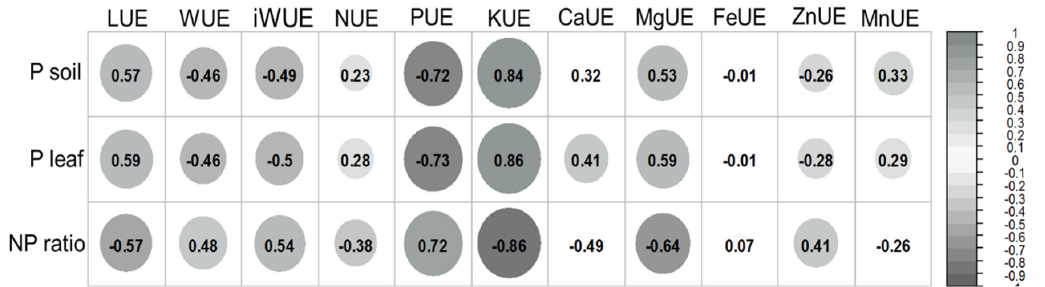
Figure 4. Correlation between phosphorus availability and resource use efficiency of Bertholletia excelsa saplings in a P-deficient Amazon Ferralsol. The significant correlations are represented by a gray circle, and the larger and darker the circle, the stronger the correlation. Abbreviations: LUE, light use efficiency; WUE, water use efficiency; iWUE, intrinsic water use efficiency; NUE, nitrogen use efficiency; PUE, P use efficiency; KUE, potassium use efficiency; CaUE, calcium use efficiency; MgUE, magnesium use efficiency; FeUE, iron use efficiency; ZnUE, zinc use efficiency; MnUE, manganese use efficiency. Phosphorus fertilization was shown to increase the total dry biomass of the saplings (Figure 5a,b). The increase in dry biomass values was observed from 200 mg P kg − 1 added in soil (Figure 5b), with greater values in plants subjected to 400 mg P kg − 1 , which showed total dry biomass that was 66% greater than the control. The maximum point of the curve occurred at the coordinates x = 306.2 mg P kg − 1 and y = 49.9 g (Figure 5b). In the control plants, about 21% of dry biomass was allocated to roots, while in plants under P only 16% of dry biomass was allocated to this organ (Figure 5c). In relation to shoot tissues (leaf + stem), control and fertilized plants allocated 79 and 86% of total dry biomass, respectively (Figure 5c).